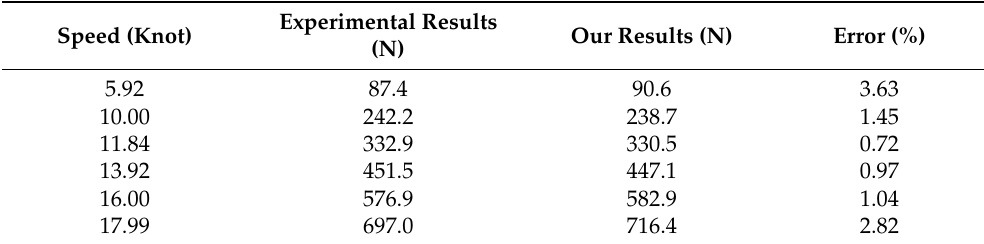
Table 10. Validation of our CFD method by comparing the numerical results with the experimental data reported in [24].